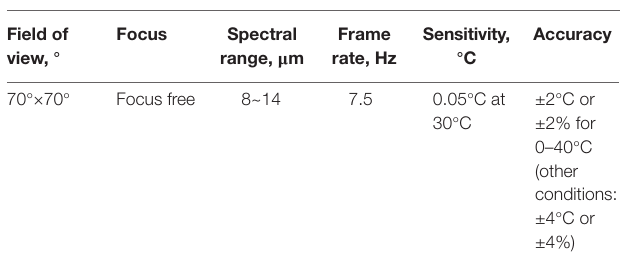
TABLE 1 | Technical specification of the thermal camera (Thermo FLEX F50B- ONL).